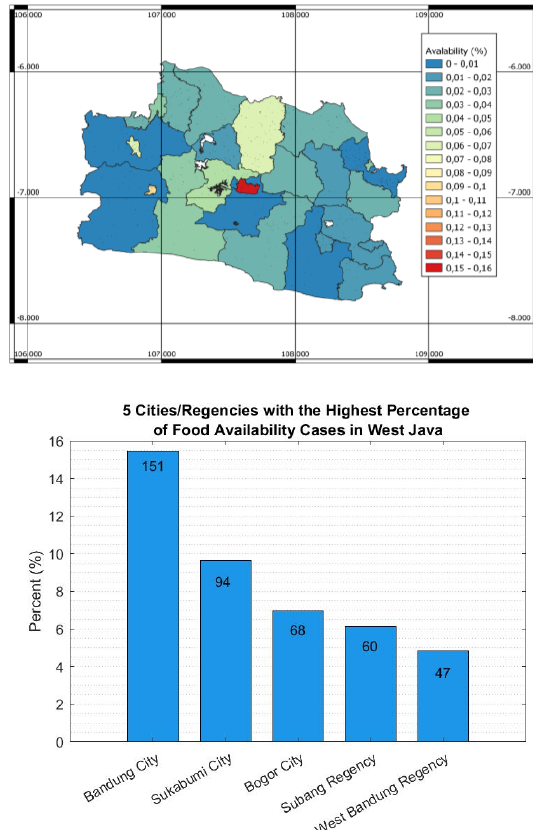
Figure 10 . Issue Distribution of food availability dan 5 Cities/Regencies with the highest percentage of food availability case in West